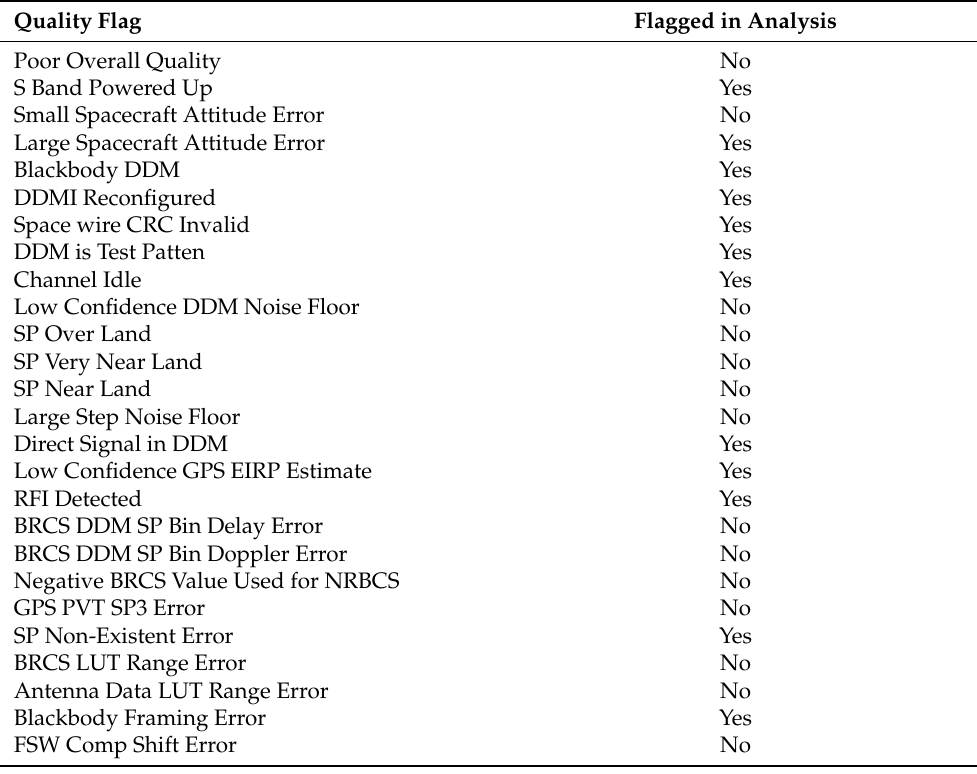
Table A2. CYGNSS L1 data quality flags used in this study, same as